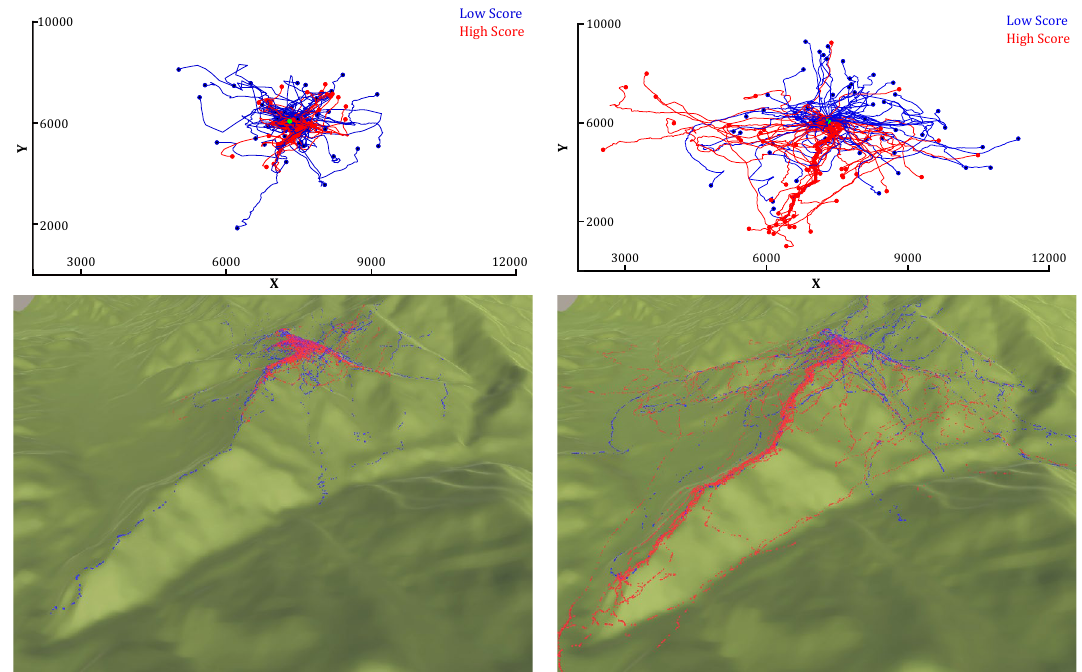
Figure 2. All search trajectories plotted for home-range players (Left) and free-range players (Right), in a 2D plane (Top) and the full 3D terrain (Bottom). Trajectories for low versus high scorers colored separately (blue versus red). The XY coordinates are in